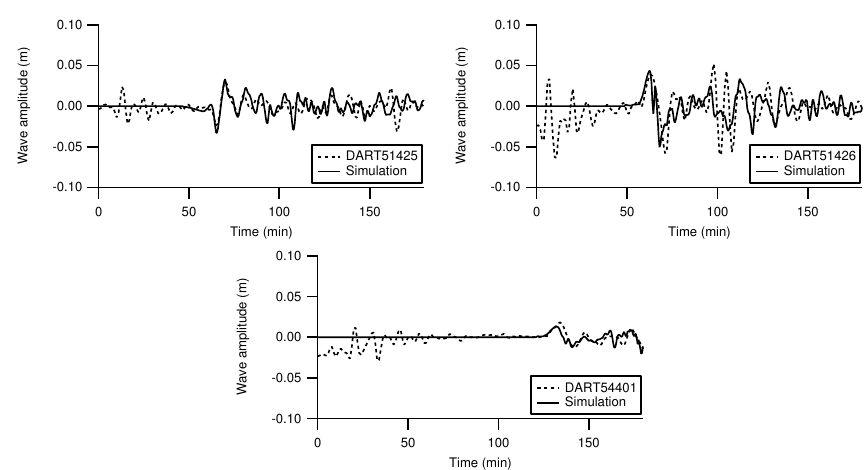
Figure 2. Comparison of the modeled waveforms from the tsunami propagation model and observed waveforms at the DART gauges. Table 2. Fault parameters used for the numerical models of tsunami inundation (Beavan et al., 2010). Fault parameters Outer rise Interface Lat ( ◦ ) − 15.542 − 15.940 Lon ( ◦ ) − 172.237 − 172.718 Strike ( ◦ ) 352 175 Dip ( ◦ ) 48 16 −